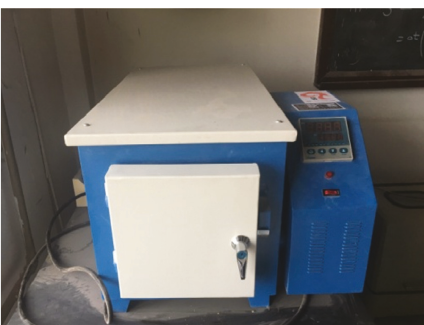
Figure 2: High-temperature box muffle furnace.